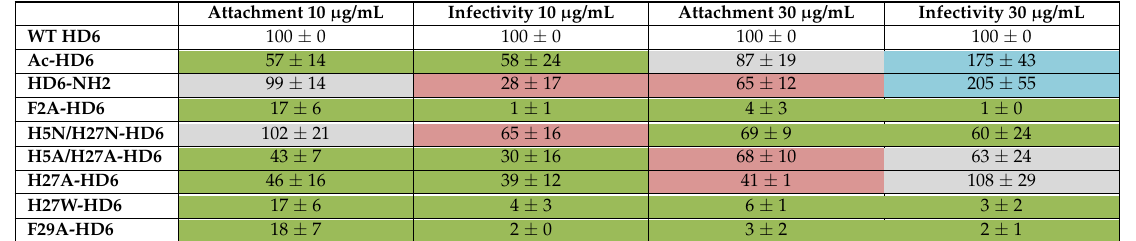
: Reduced : Reduced activity,